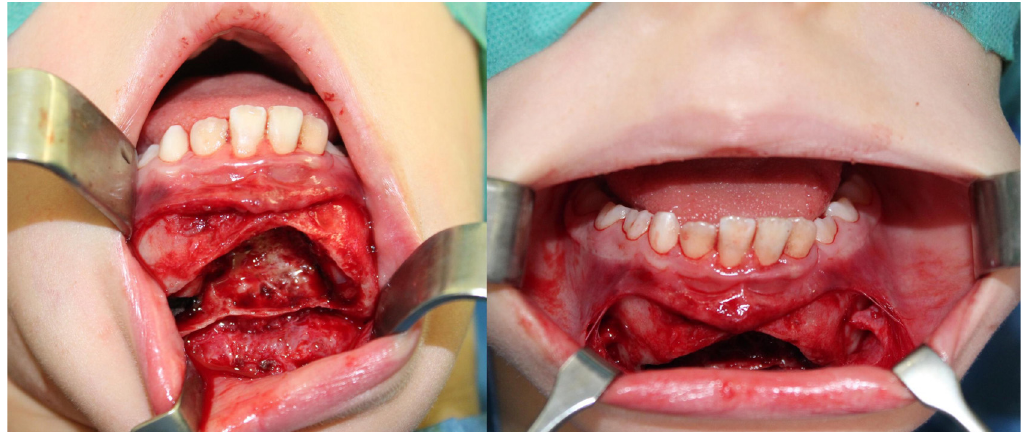
Fig. 4. Left: surgical site after lesion enucleation. Right: showing the emergence of the two mental nerves.